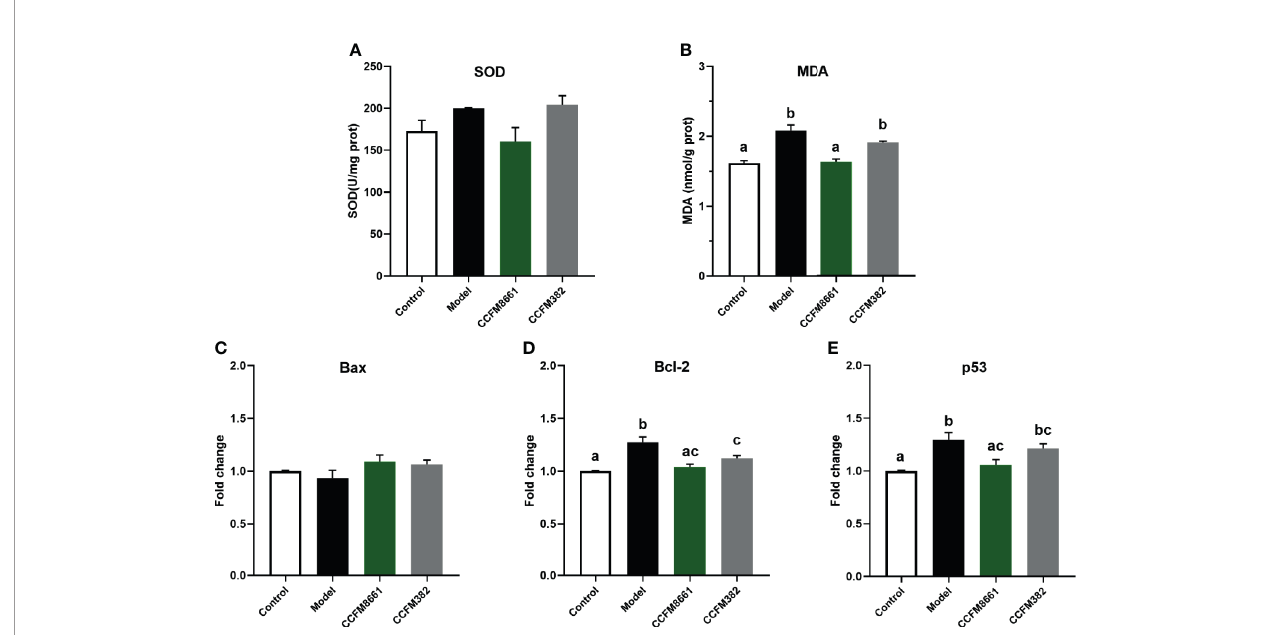
FIGURE 4 | Effect of L. plantarum CCFM8661 on oxidative stress- and tumor-related parameters in the brain. (A) SOD activity, (B) MDA level, (C – E) mRNA expression levels of apoptosis-related genes in brain. The different letters indicate signi fi cant difference between groups ( P < 0.05 ).